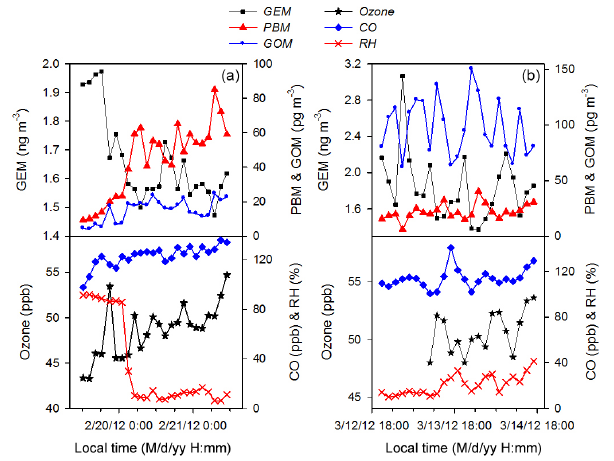
Figure 3. Time series of GEM, PBM, GOM, ozone, CO, and rela- tive humidity (RH) during high PBM event #12 (a) and #19 (b)